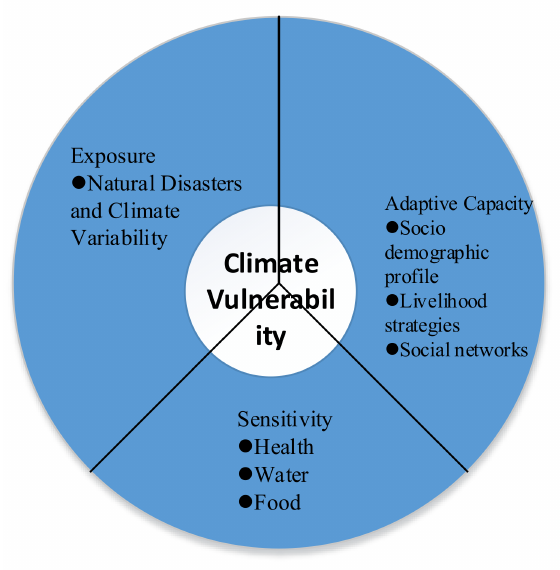
Figure 2. Grouping of the seven main indicators into the